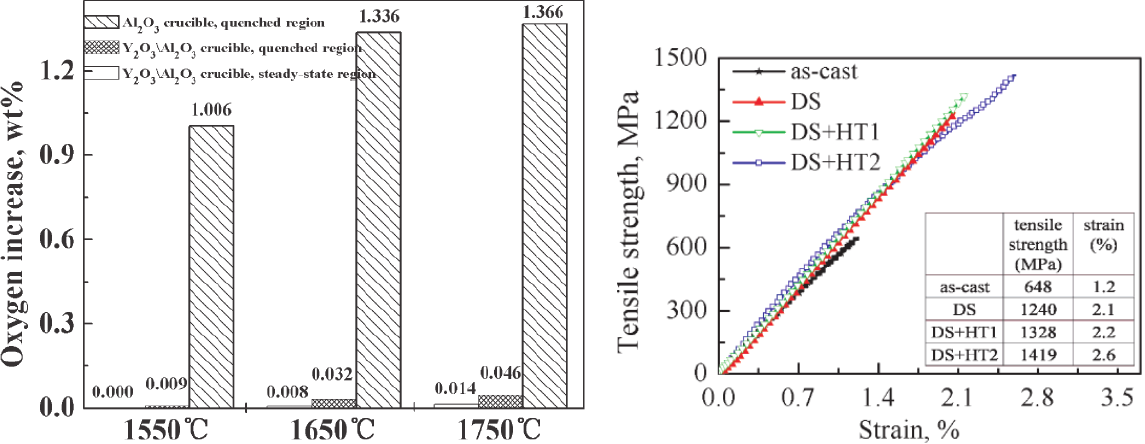
Fig. 5: Oxygen increase of the steady-state and quenched regions in the DS ingots using different crucibles.